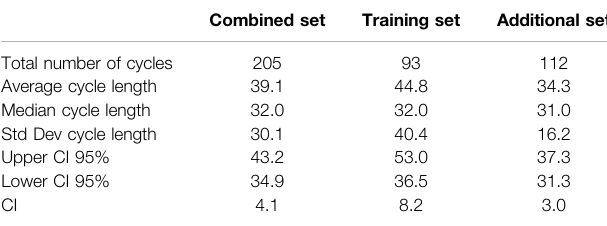
TABLE 3 | Cycle comparison by data set